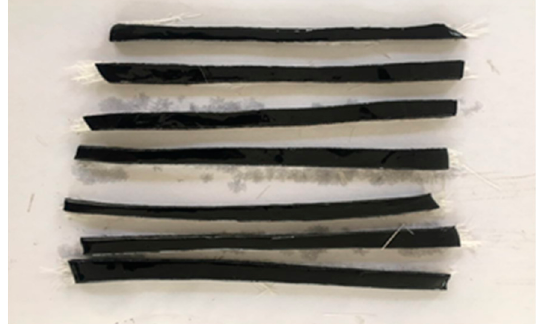
Figure 2. Samples for the determination of limit oxygen index. Table 3. Results of limit oxygen index test.